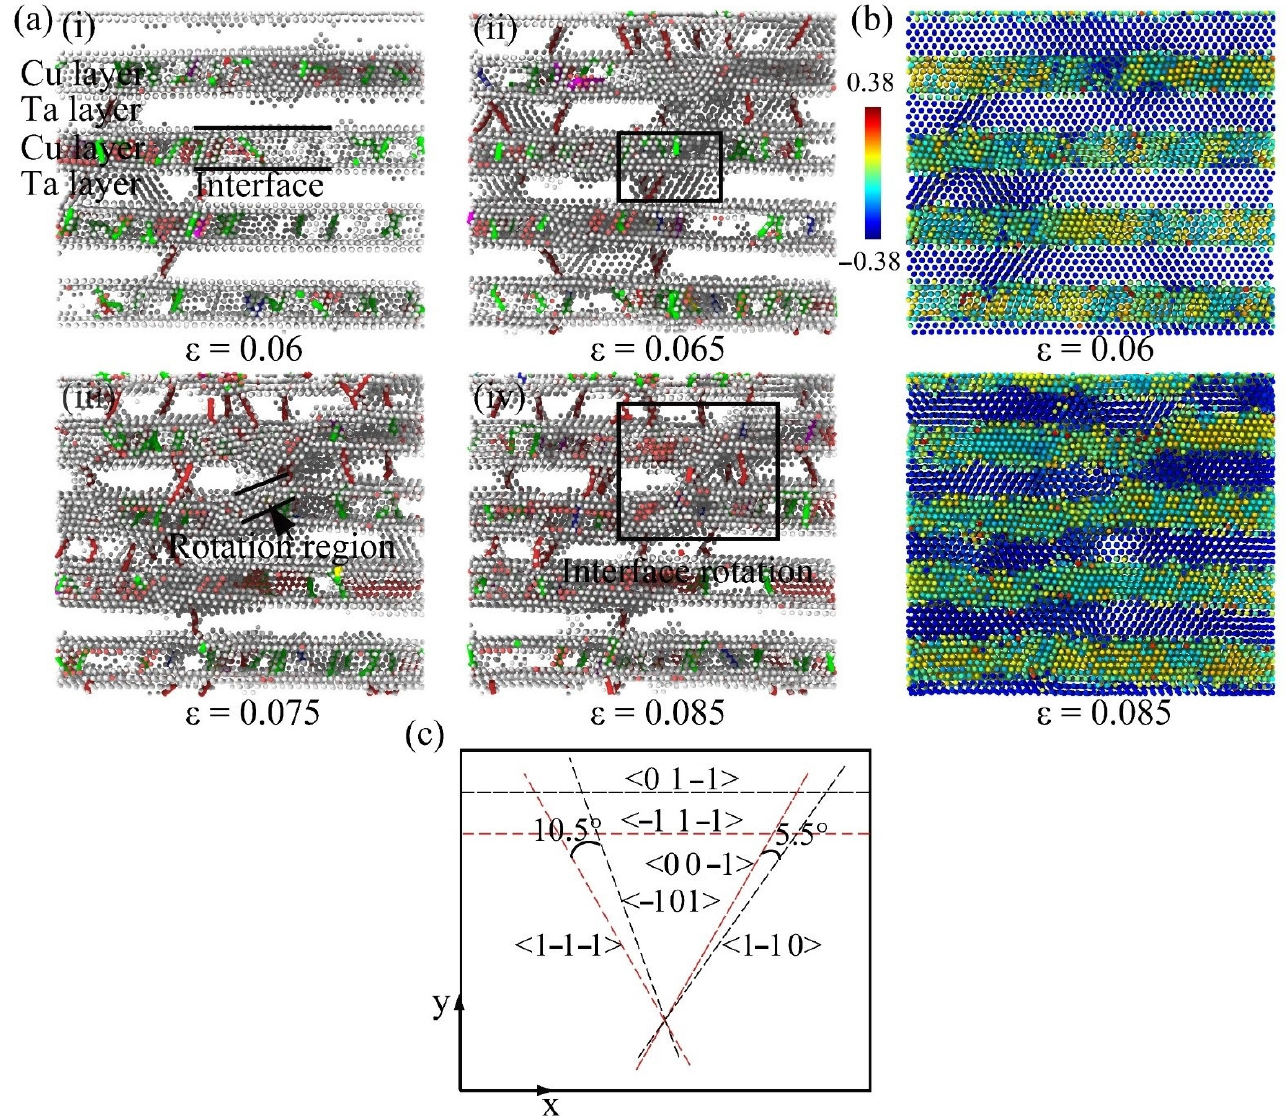
Figure 5. ( a ) Snapshots of the local atomic defect evolution for interface rotation. Images ( i – iv ) corre- spond to applied strains at 0.06, 0.065, 0.075, 0.085, respectively. ( b ) Misorientation and ( c ) trajectories of the intersection of the {1 1 1} Cu and {1 1 0} Ta slip planes with the KS orientation-related interface. Three black and red dashed lines represent the intersection of the interface plane with the {1 1 1} Cu and {1 1 0} Ta slip planes, respectively. Figure 6a and b exhibit snapshots of the atomic defects of the shear band formation.